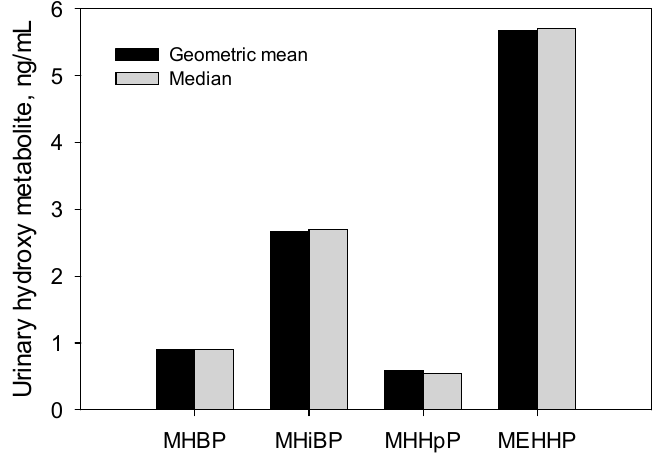
Figure 4. Geometric mean and median concentrations of the hydroxy metabolites of dibutyl phthalate (DBP), diisobutyl phthalate (DiBP), and di-2-ethylhexyl phthalate (DEHP) in urine samples from the 2015–2016 National Health and Nutrition Examination Survey (NHANES) compared with MHHpP (2018–2019 current study). Monohydroxybutyl phthalate (MHBP)-metabolite of DBP; monohydroxy-isobutyl phthalate (MHiBP)-metabolite of DiBP; mono-2-ethyl-5-hydroxyhexyl phthalate (MEHHP)-metabolite of DEHP.